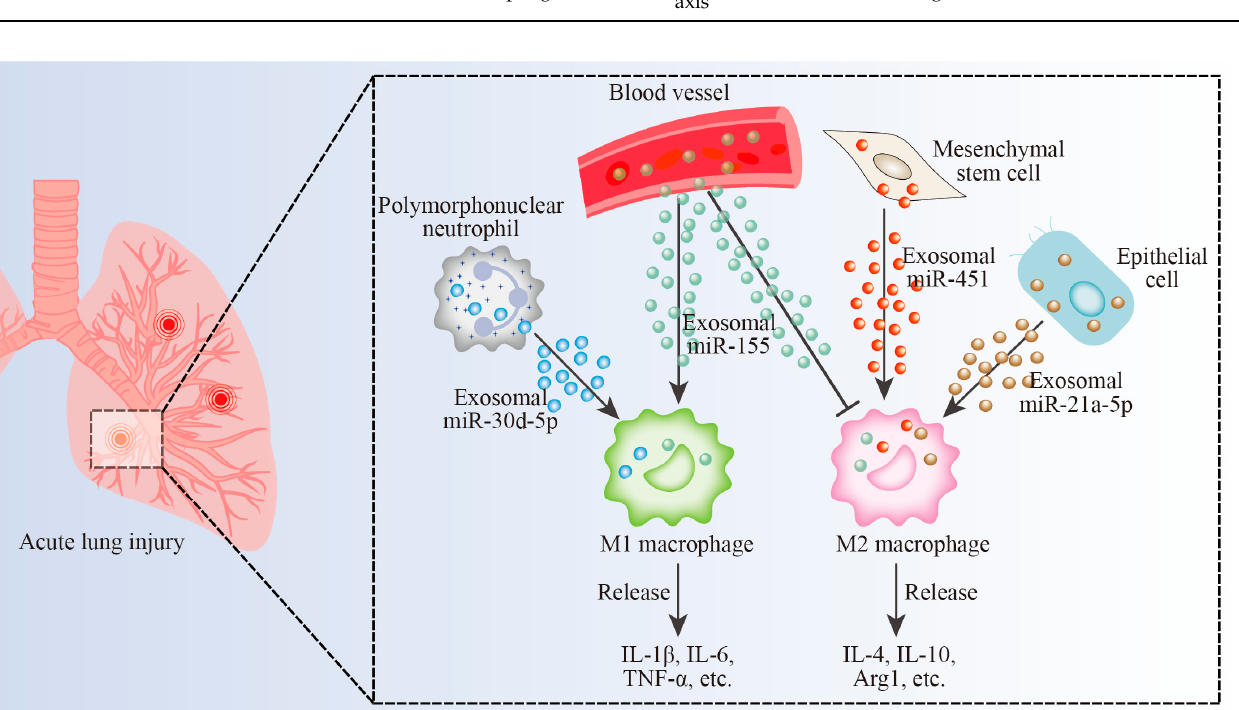
Figure 2. Exosomal miRNAs govern macrophage polarization in ALI. PMN-derived miR-30d-5p promotes M1 polarization. Blood-sourced miR-155 stimulates and represses M1 polarization and M2 polarization, respectively. MSC-derived miR-451 and epithelial cell-derived miR-21a-5p induce M2 polarization. M1 macrophages produce pro-inflammatory cytokines (i.e., IL-1 β , IL-6, TNF- α , etc.) and M2 macrophages generate anti-inflammatory cytokines, including IL-4, IL-10, Arg1, etc.